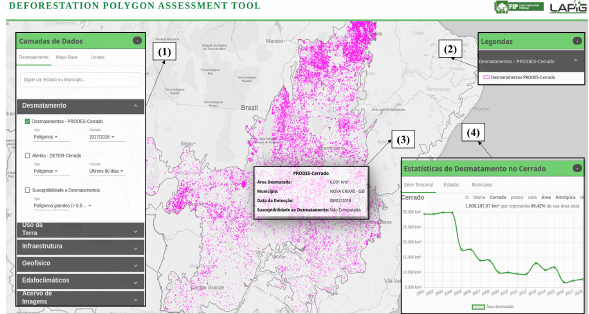
Figure 5. DPAT official initial page with its interactive map and boxes.